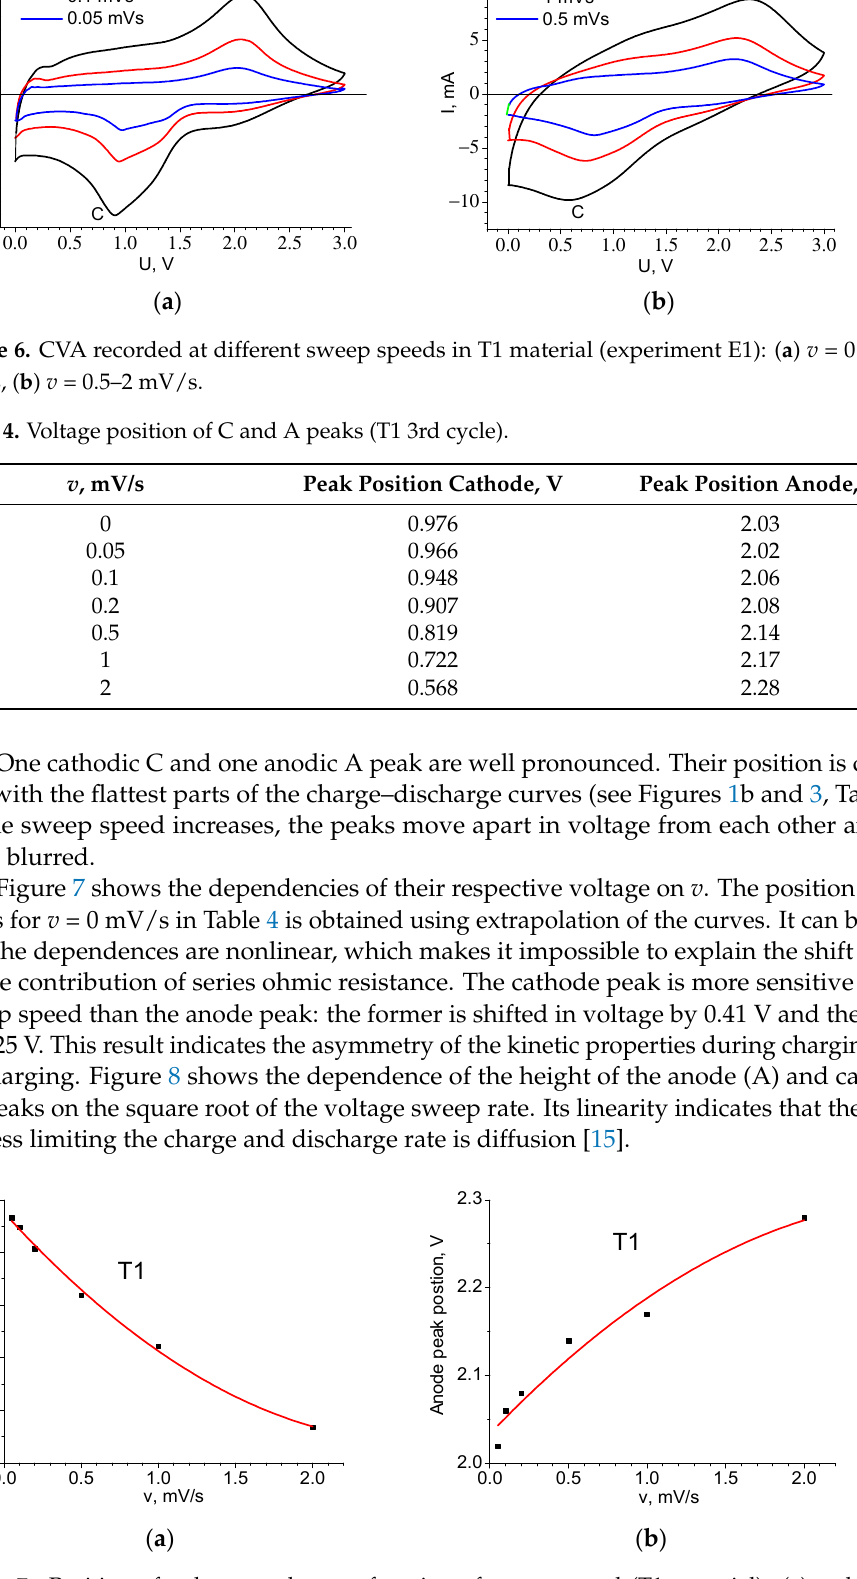
Figure 7. Position of voltage peaks as a function of sweep speed (T1 material): ( a ) cathode C; ( b ) anode A.